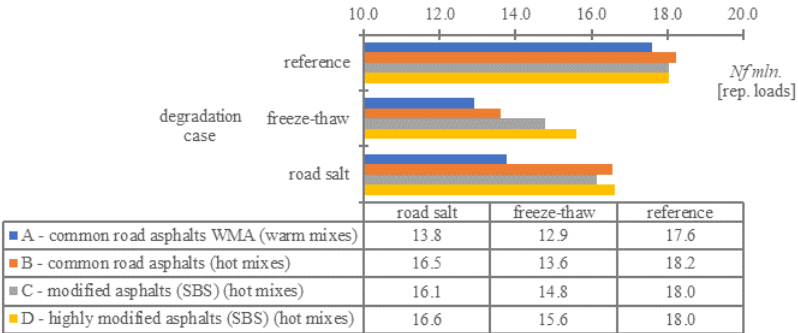
Figure 10. KR5 typical flexible pavement fatigue life variability caused by water, frost, or road salt. 2.